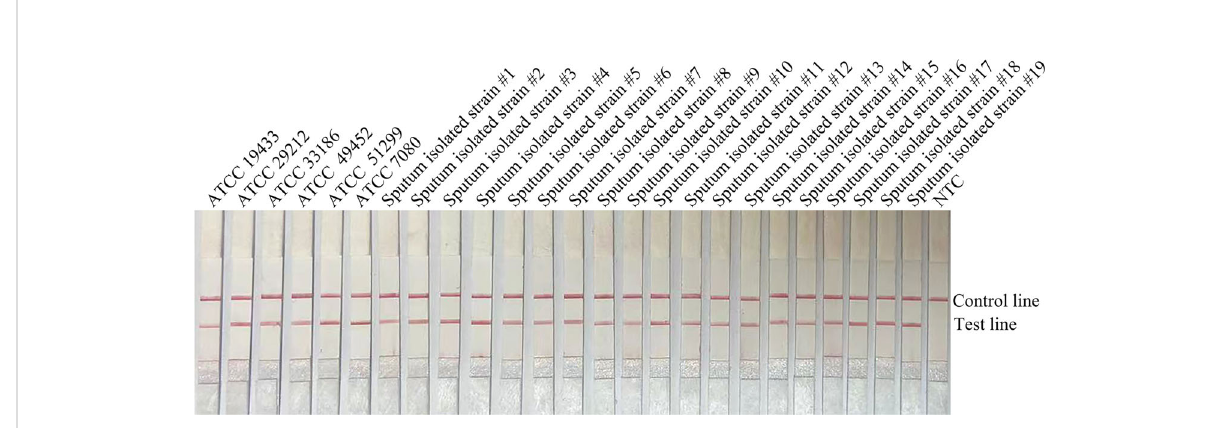
FIGURE 2 Compatibility con fi rmation. Image showing the RPA-LFS results for different reference and isolated strains of E. faecalis . The name of each bacterial template is indicated on the top of each lane. NTC, no template control. Image represents the results of three independent